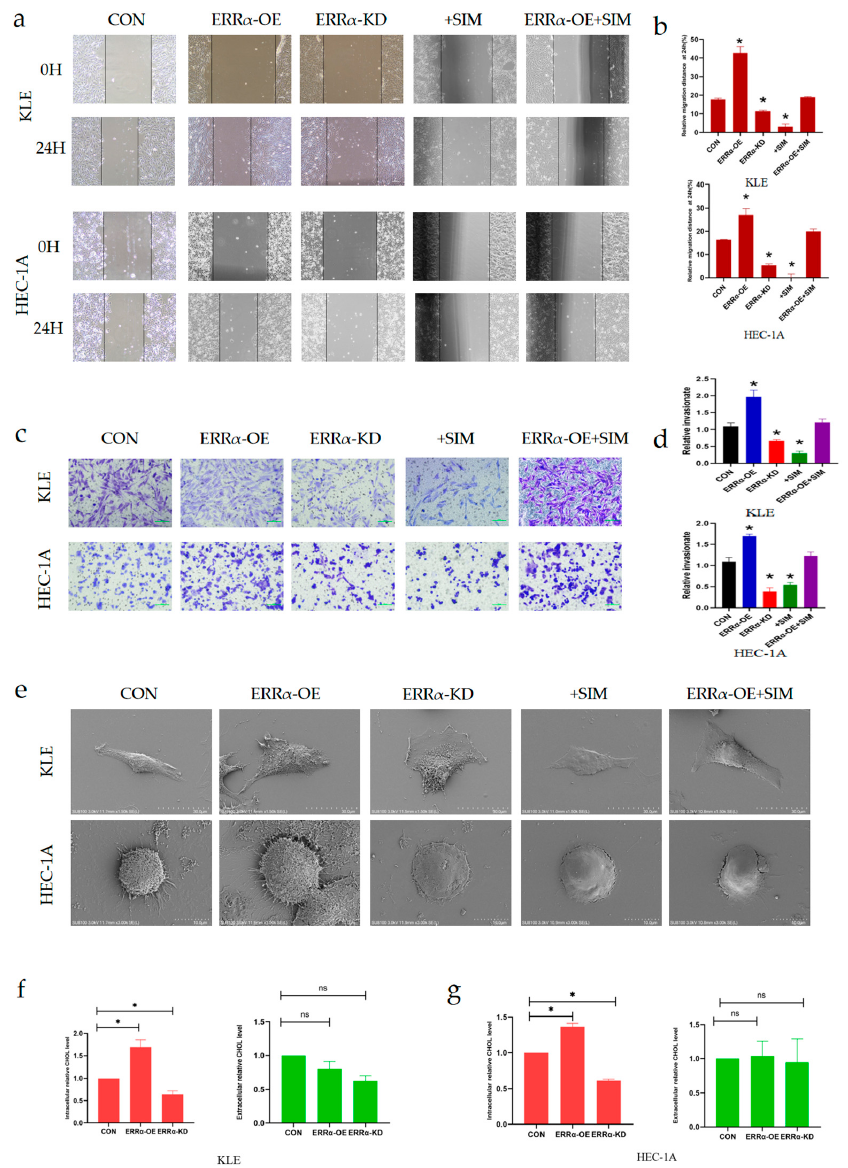
Figure 5. ERR α promotes intracellular cholesterol metabolism and enhances the formation of in- vadopodia by targeting HMGCS1 . ( a , b ) Effects of the ERR α –HMGCS1 axis and simvastatin treatment for 24 h on wound healing in ERR α -over-expressing and control EC cells, and the corresponding sta- tistical analysis results (magnification, 200 × ; scale bars, 100 µ m). ( c , d ) Effects of the ERR α –HMGCS1 axis and simvastatin treatment for 24 h on transwell chamber invasion by ERR α -over-expressing and control EC cells, and the corresponding statistical analysis results (magnification, 200 × ; scale bars, 100 µ m). ( e ) Representative scanning electron microscope (SEM) micrographs of KLE and HEC-1A cells. Pseudopod formation was affected by the ERR α –HMGCS1 axis and simvastatin treatment for 24 h (scale bar, 100 µ m). ( f , g ) The intracellular and extracellular levels of cholesterol in EC cells after ERR α and HMGCS1 up- and down-regulation, as detected using a colorimetric method. *, indicates statistical significance. Statistical tests: Student’s t -test or